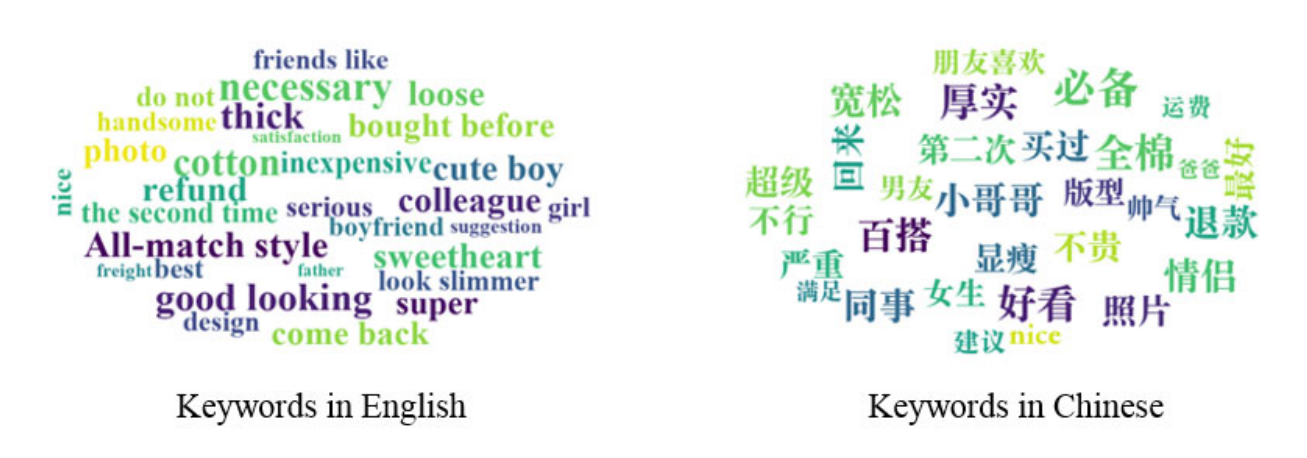
Figure 6. The most different words under different product consideration (16 products).